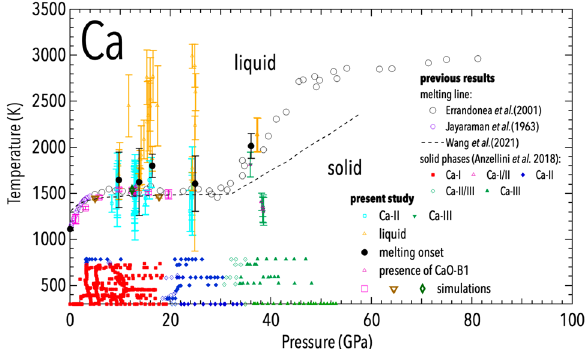
Figure 3. Phase diagram of Ca as measured (light blue, green and gold symbols) and simulated (empty purple squares, brown triangles and green diamond symbols) in the present study, compared to previous experimental results obtained in DAC from resistive 6 and laser-heating 8 experiments and in piston-cylinder apparatus 9 . Results obtained from ab initio molecular dynamic simulations are also reported for comparison 36 .